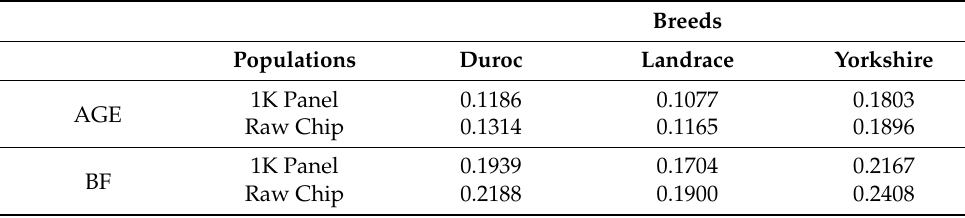
Table 2. Prediction accuracies of GEBVs calculated by imputed 1K panel and raw chip.